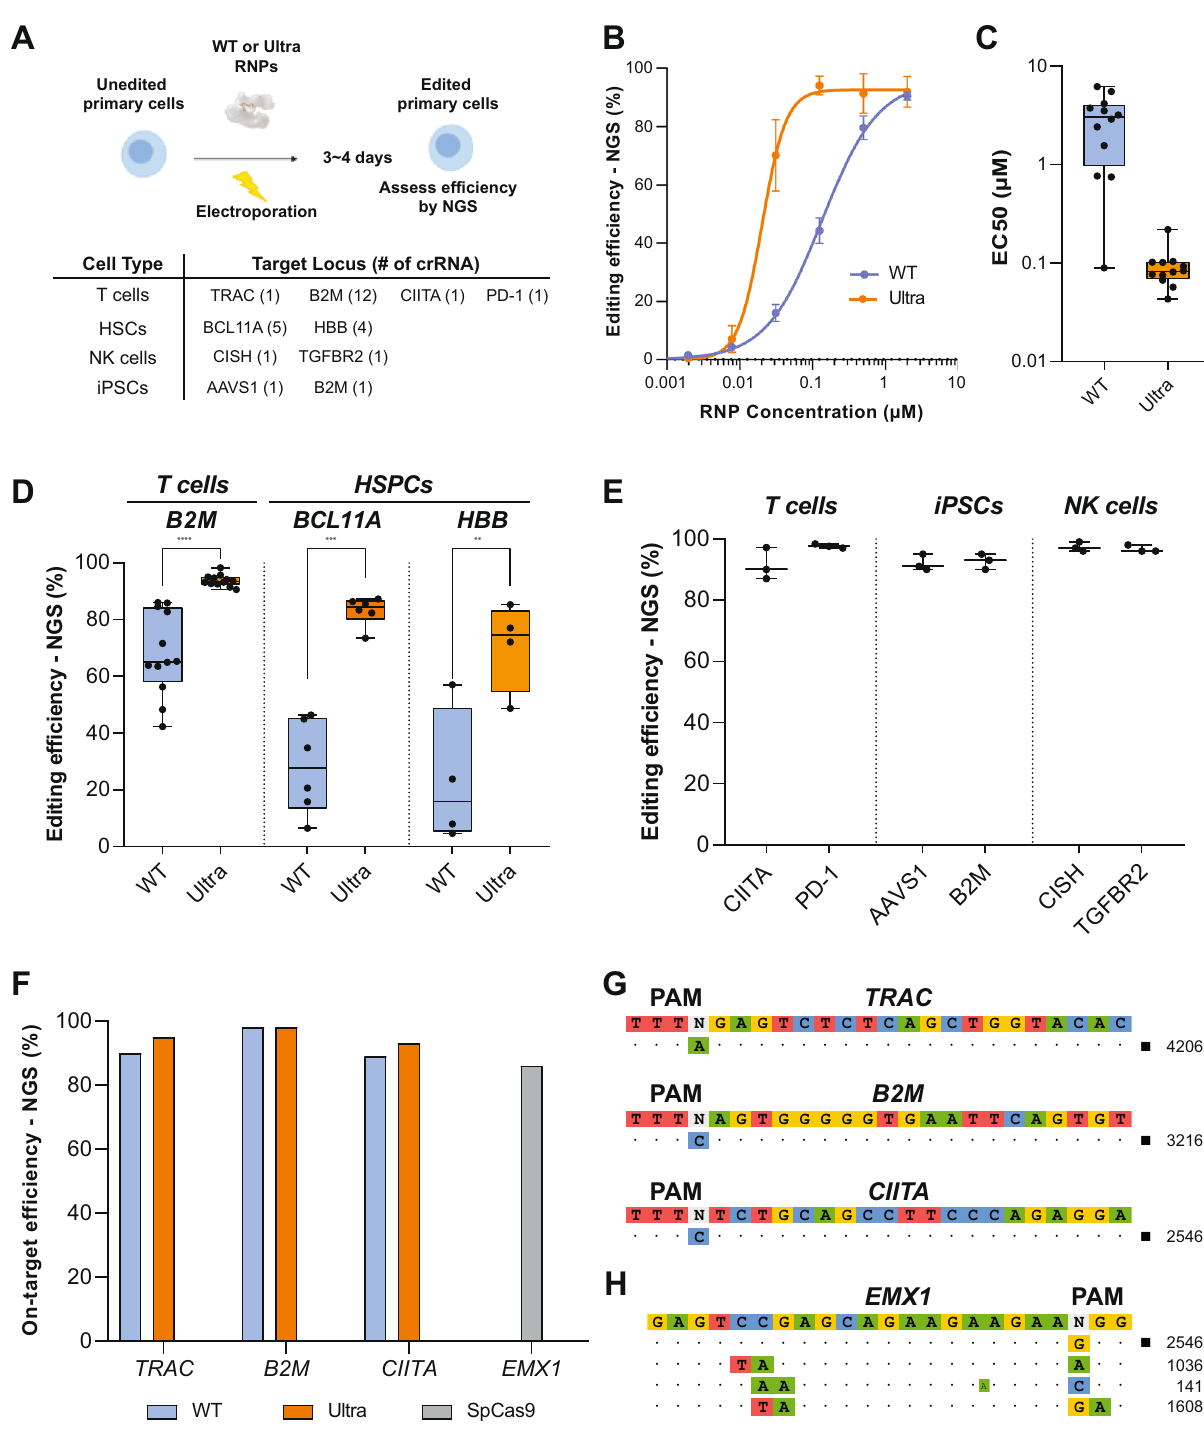
we further compared the activity of these AsCas12a variants all with the same NLS in HEK293 cells over 8 targets (Fig. 4E). Consistent with the original report, enCas12a doubled the editing of WT nuclease (median ef fi ciency: 15% vs. 30%). However, it is still only half as active as AsCas12a Ultra (60%). Our fi